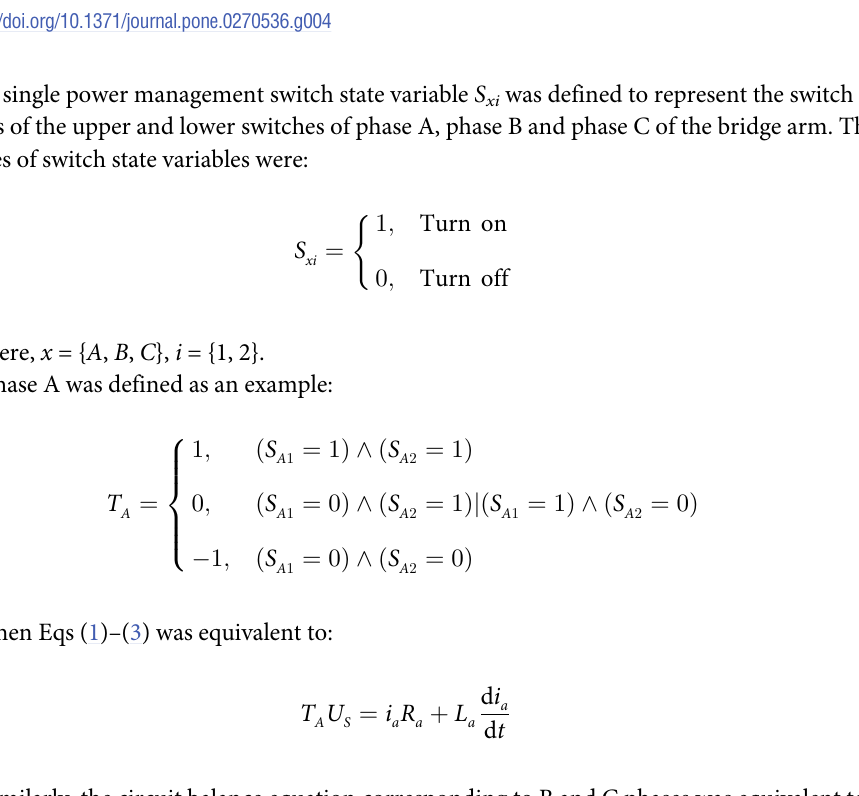
Fig 4. Current sensor detection